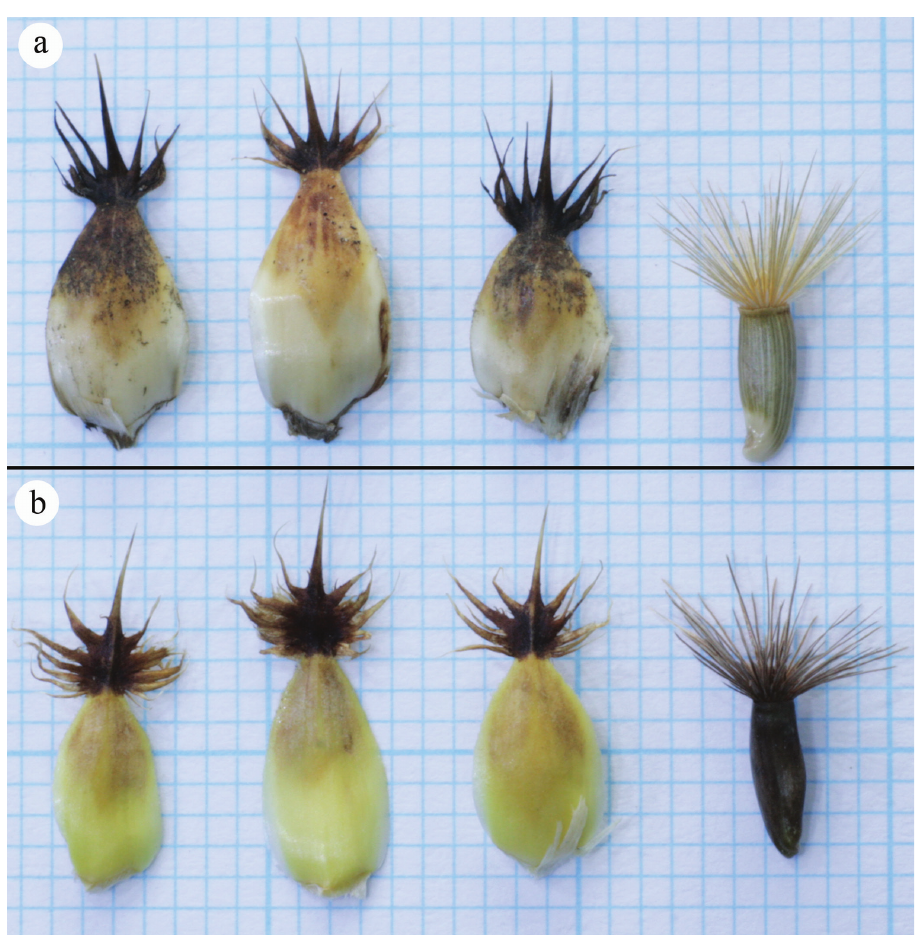
Figure 4. The character comparison of the median phyllary appendages and achenes of Centaurea zigan- ensis ( a ) and Centaurea drabifolioides ( b